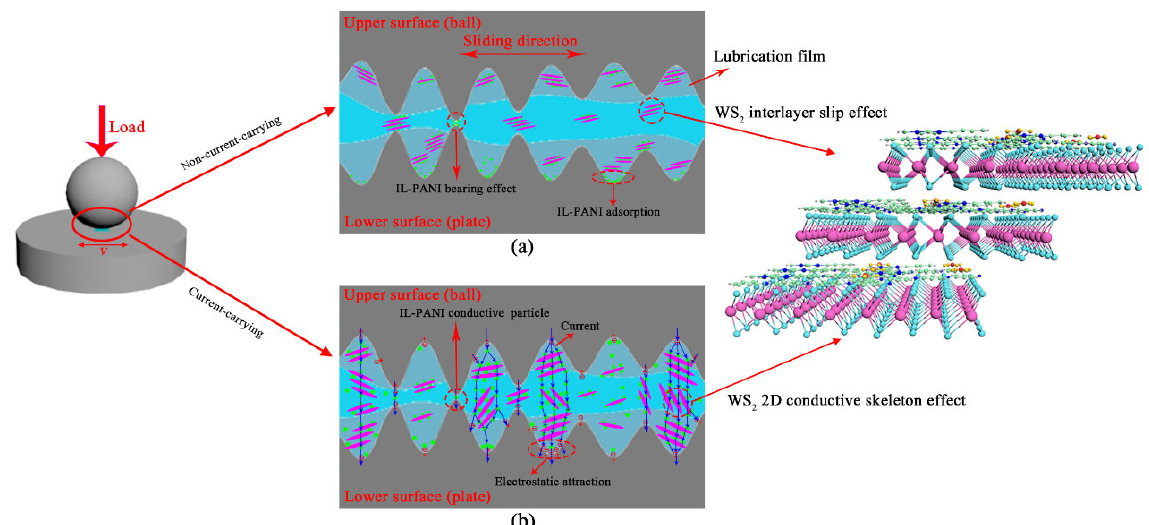
Fig. 11 Schematic illustrations of (a) lubrication mechanism and (b) conduction mechanism of IL-PANI/WS 2 as an additive in grease during friction